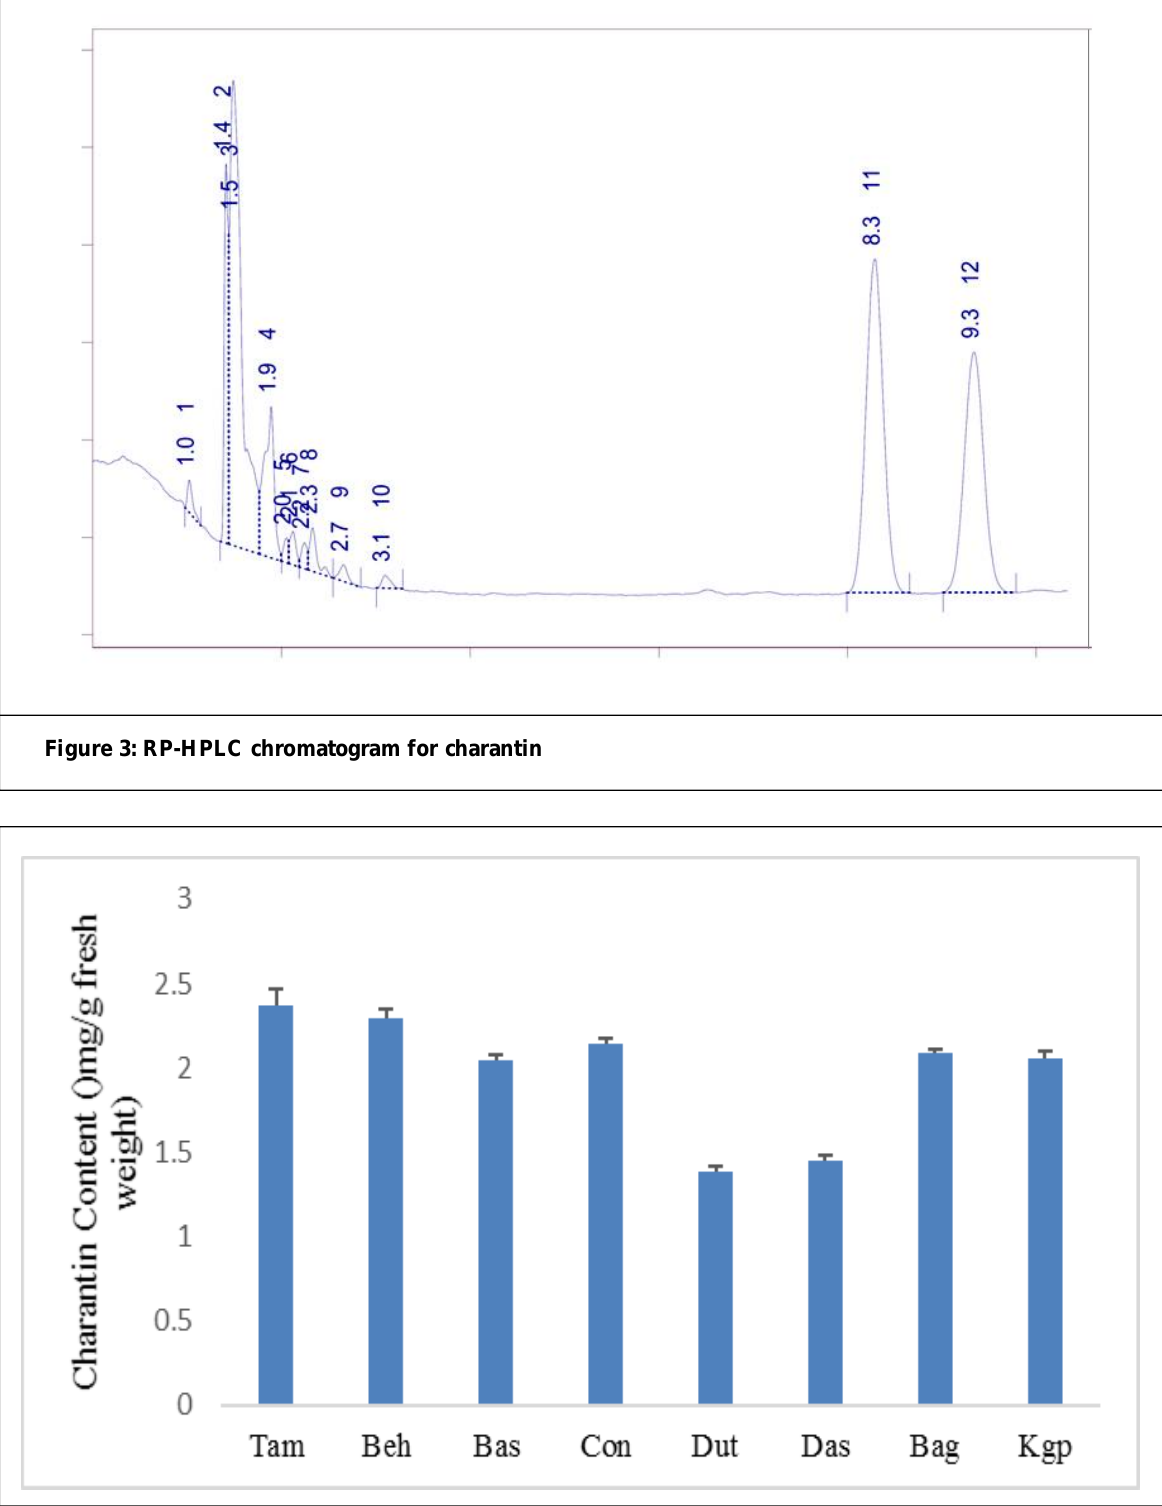
Figure 4: Charantin variation across different cultivation